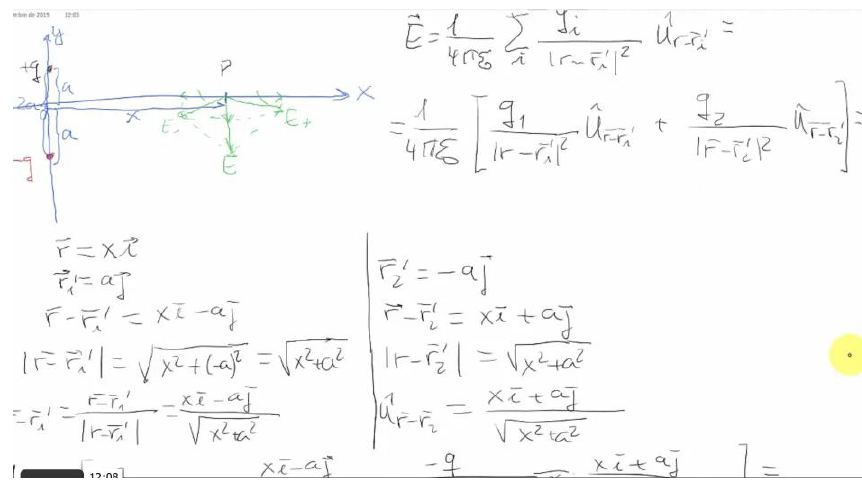
Figure 1. Example of a video created with a digitalizing table: https://vimeo.com/146556665.